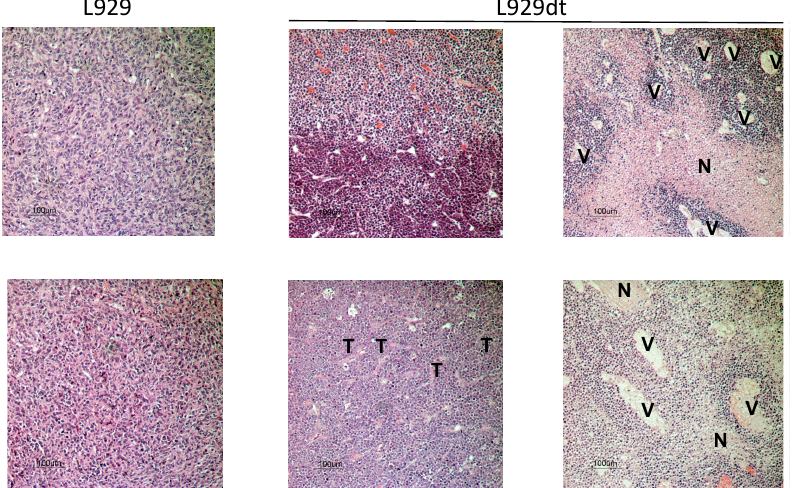
Figure 4. In vivo tumor development of L929 and L929dt cells in athymic mice. ( A , B ) 1 × 10 6 L929 or L929dt living cells were injected s.c., respectively, in groups of 4 mice each. After three weeks, mice were sacrificed and tumors surgically excised. ( A ) Examples of the appearance and size of L929 or L929dt-derived tumors; ( B ) Mean ± SD of the tumor weights, expressed in grams. *, p < 0.05. ( C , D ) 125,000 L929 or L929dt living cells were injected intraesplenically, respectively, in groups of 5 mice each. After three weeks, mice were sacrificed and spleens surgically excised. ( C ) Examples of the appearance and size of L929 and L929dt-derived spleen tumors (squared areas); ( D ) Mean ± SD of tumor volumes, expressed in mm 3 . *, p < 0.05.